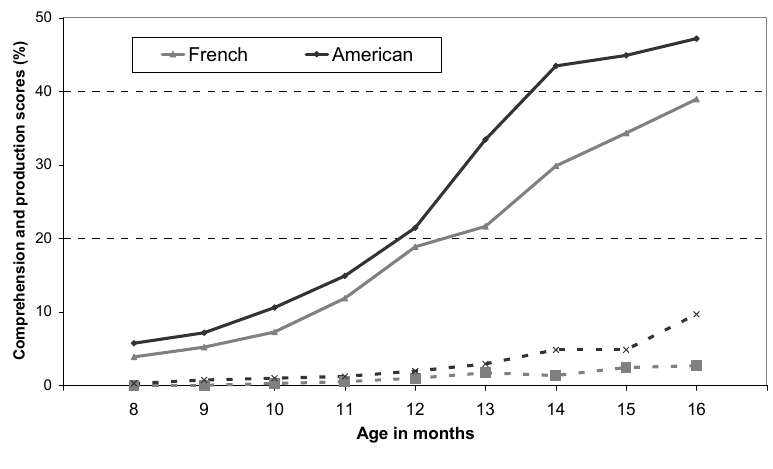
Figure 3: Comprehension and production scores, in percentages, on the American and French CDI. American data from Fenson et al. (1994), French data from Kern (2007). Comprehension scores are shown in full lines, production scores in dotted